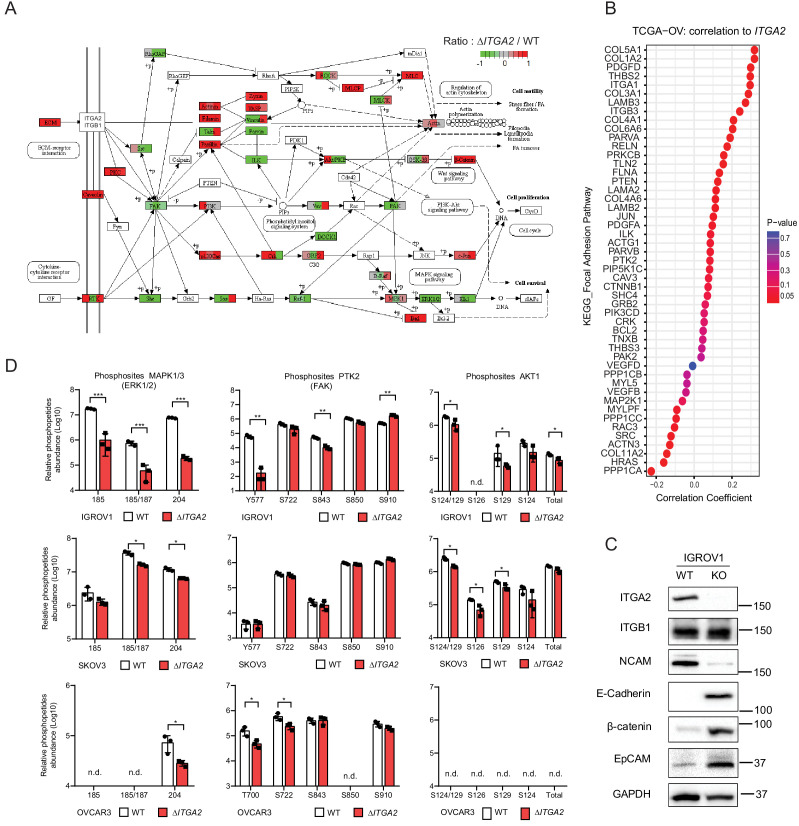
Phosphoproteomics identify ITGA2-dependent activation of the FAK and MAPK signaling axis.(A) KEGG PathView depicts up- (red) and downregulated (green) phosphoproteins of the focal adhesion pathway comparing ΔITGA2 to WT cells. (B) Dot plot highlights the Pearson correlation coefficient of ITGA2 expression to the genes involved in KEGG_focal adhesion pathway from TCGA-ovarian cancer RNA-seq dataset. (C) Western blot analysis shows altered expression of epithelial adhesion proteins in WT and ΔITGA2 cells. (D) Assessment of the relative abundance of MAPK1/MAPK3, FAK, and AKT phosphopeptides in WT and ΔITGA2 cells by phosphoproteomics.